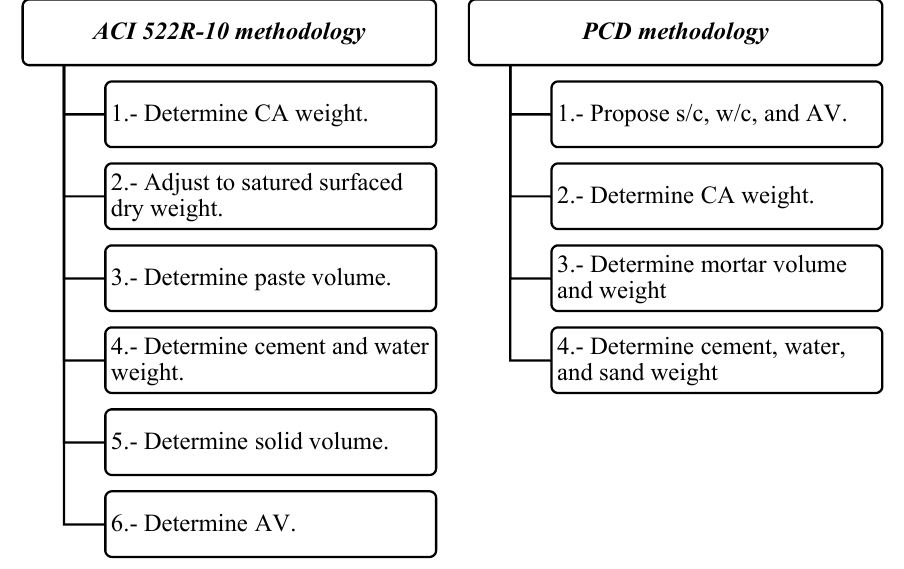
Figure 1. Comparative dosage steps of the ACI 522R-10 and porous concrete design (PCD) methodologies.